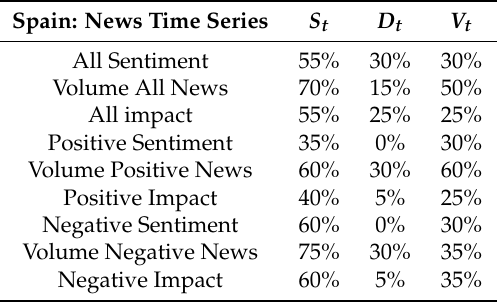
Table 2. Percentage of significant correlations between spread and sentiment time series for short-term bonds issued by Spain. Spain: News Time Series S t D t V